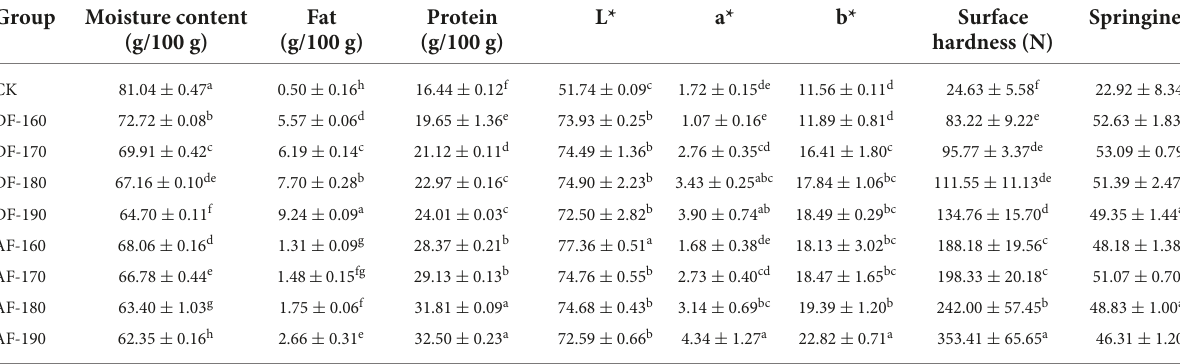
TABLE 1 Effect of frying method and temperature on basic nutritional components, color, and texture of shrimp meat.